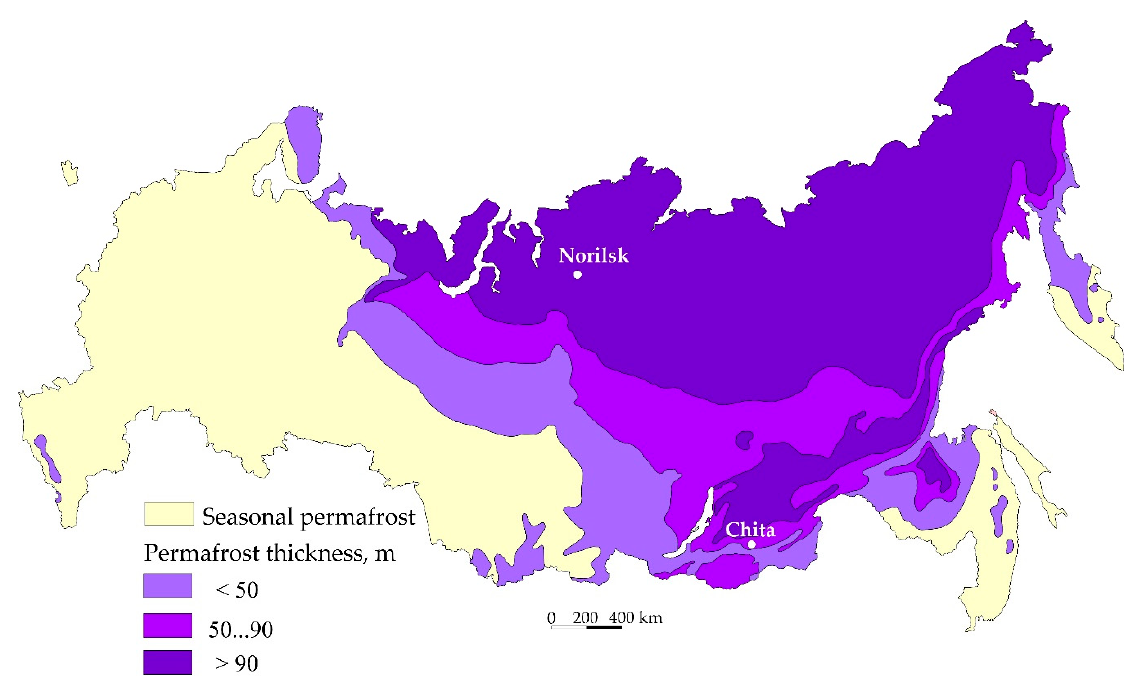
Figure 1. Map of permafrost distribution in the Russian Federation [5].